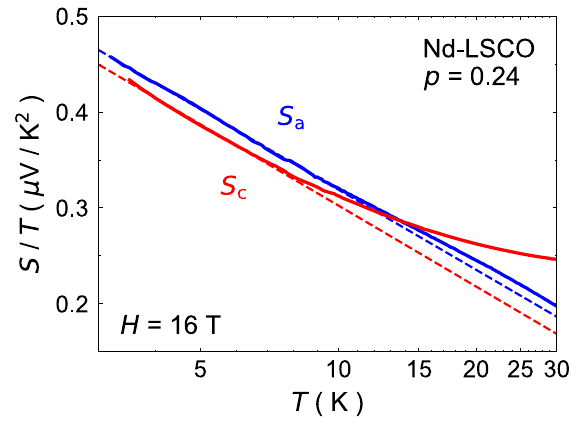
FIG. 3. In-plane ( S a , blue) and out-of-plane ( S c , red) Seebeck coefficients of Nd-LSCO at p ¼ 0 . 24 > p ⋆ plotted as S=T vs log ð T Þ at H ¼ 16 T. Note the logarithmic dependence below approximately 10 K, where S is essentially isotropic ( S a ≃ S c